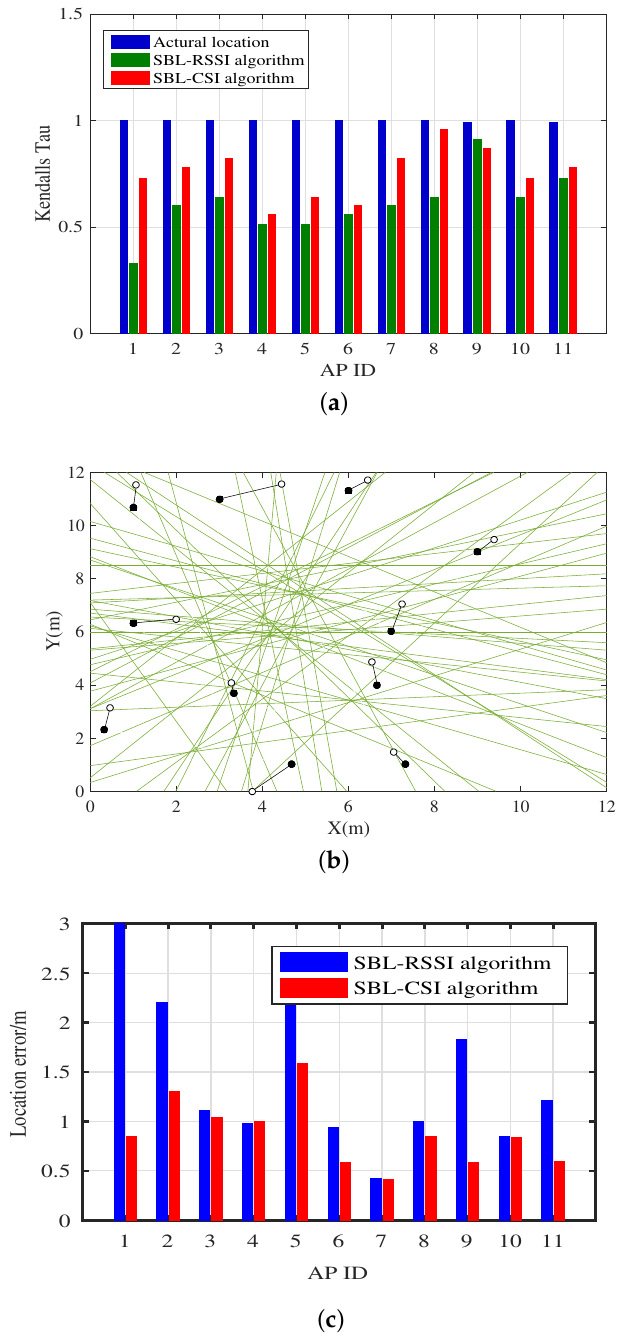
Figure 9. ( a ) Comparison of Kendall’s Tau among the true location, SBL-RSSI and SBL-CSI; ( b ) evaluation of SBL-CSI algorithm; ( c ) comparison of the positioning error of the SBL-CSI and SBL-RSSI